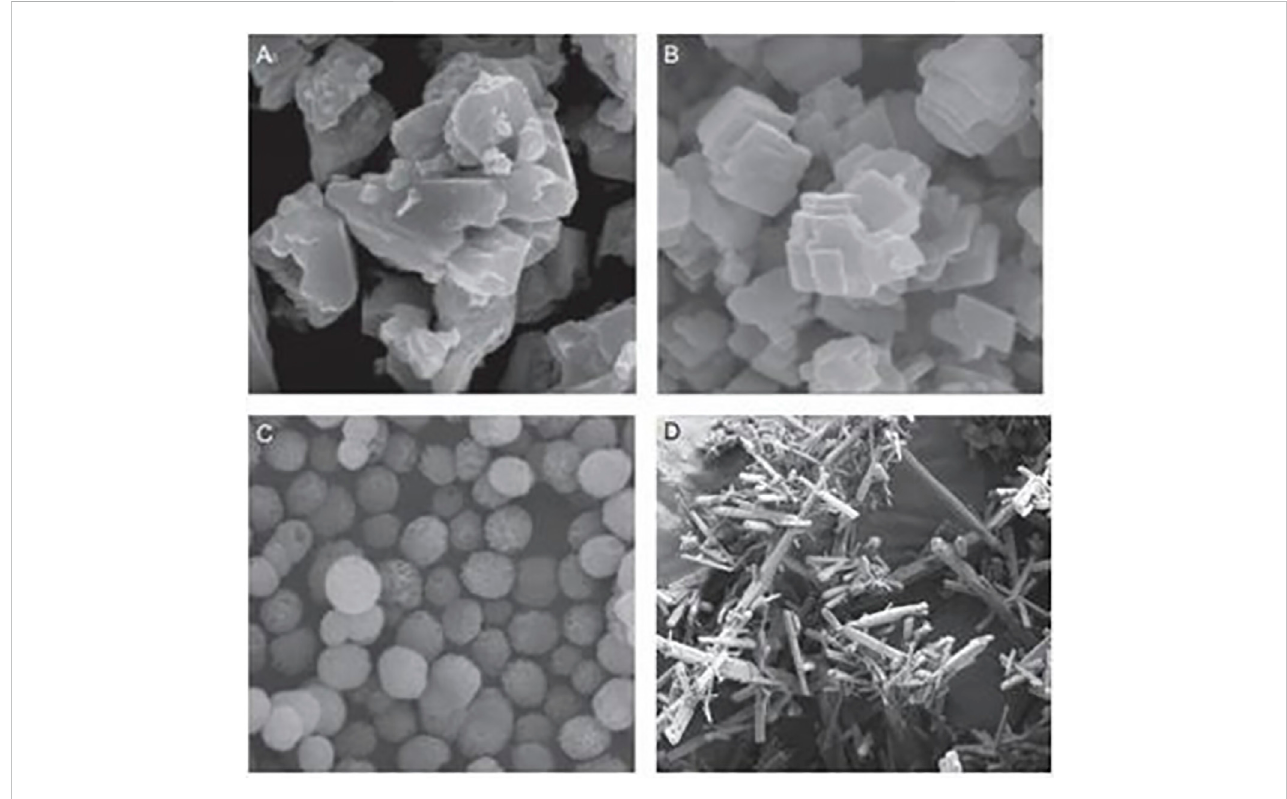
FIGURE 2 SEM images of different CaCO 3 types (A) amorphous calcite; (B) rhombohedral calcite; (C) vaterite and (D) aragonite (Al Omari et al.